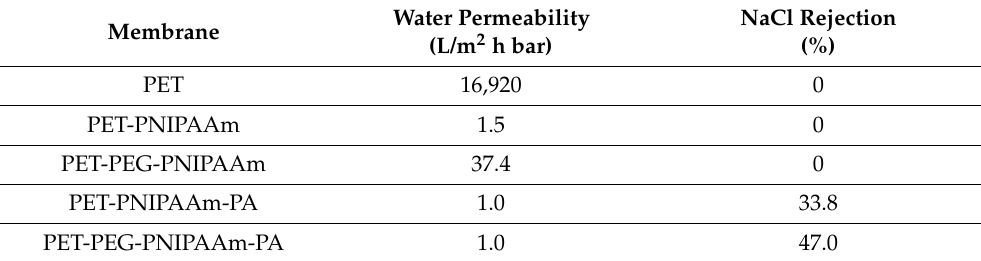
Table 3. Overview of membrane water permeability and salt rejection.